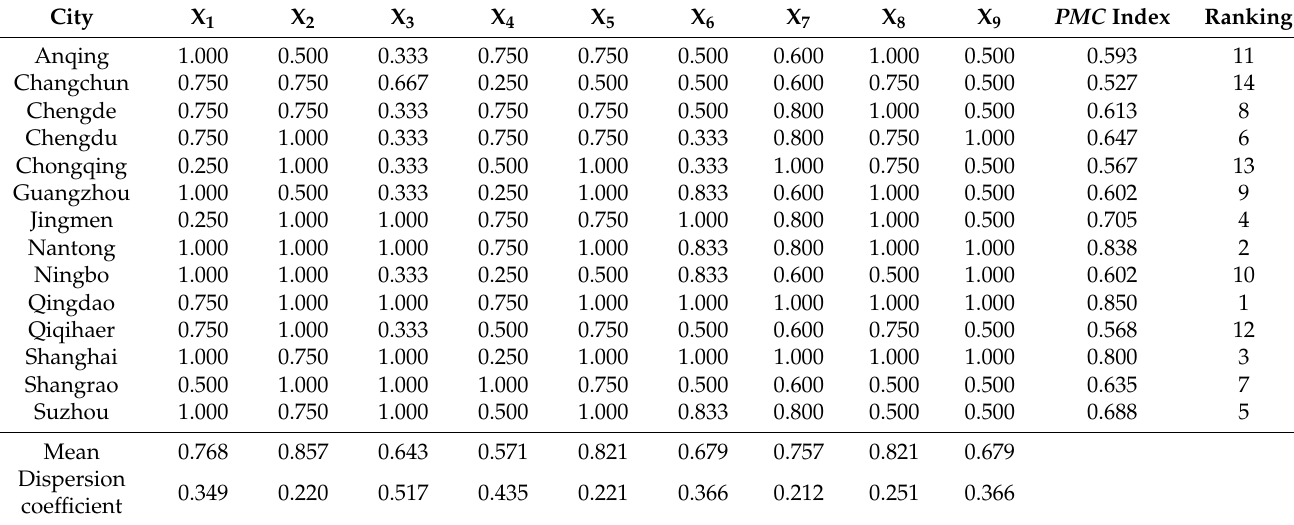
Table 3. PMC index and ranking of LTCI policy models in 14 pilot cities.